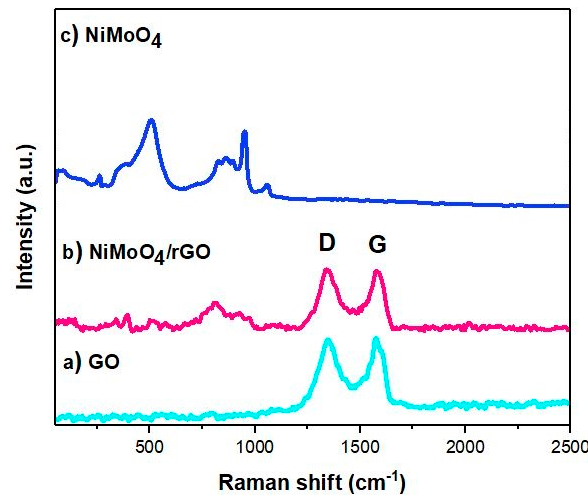
Figure 4. Raman spectrum of the GO, NiMoO 4 , and NiMoO 4 /3D-rGO nanocomposites.